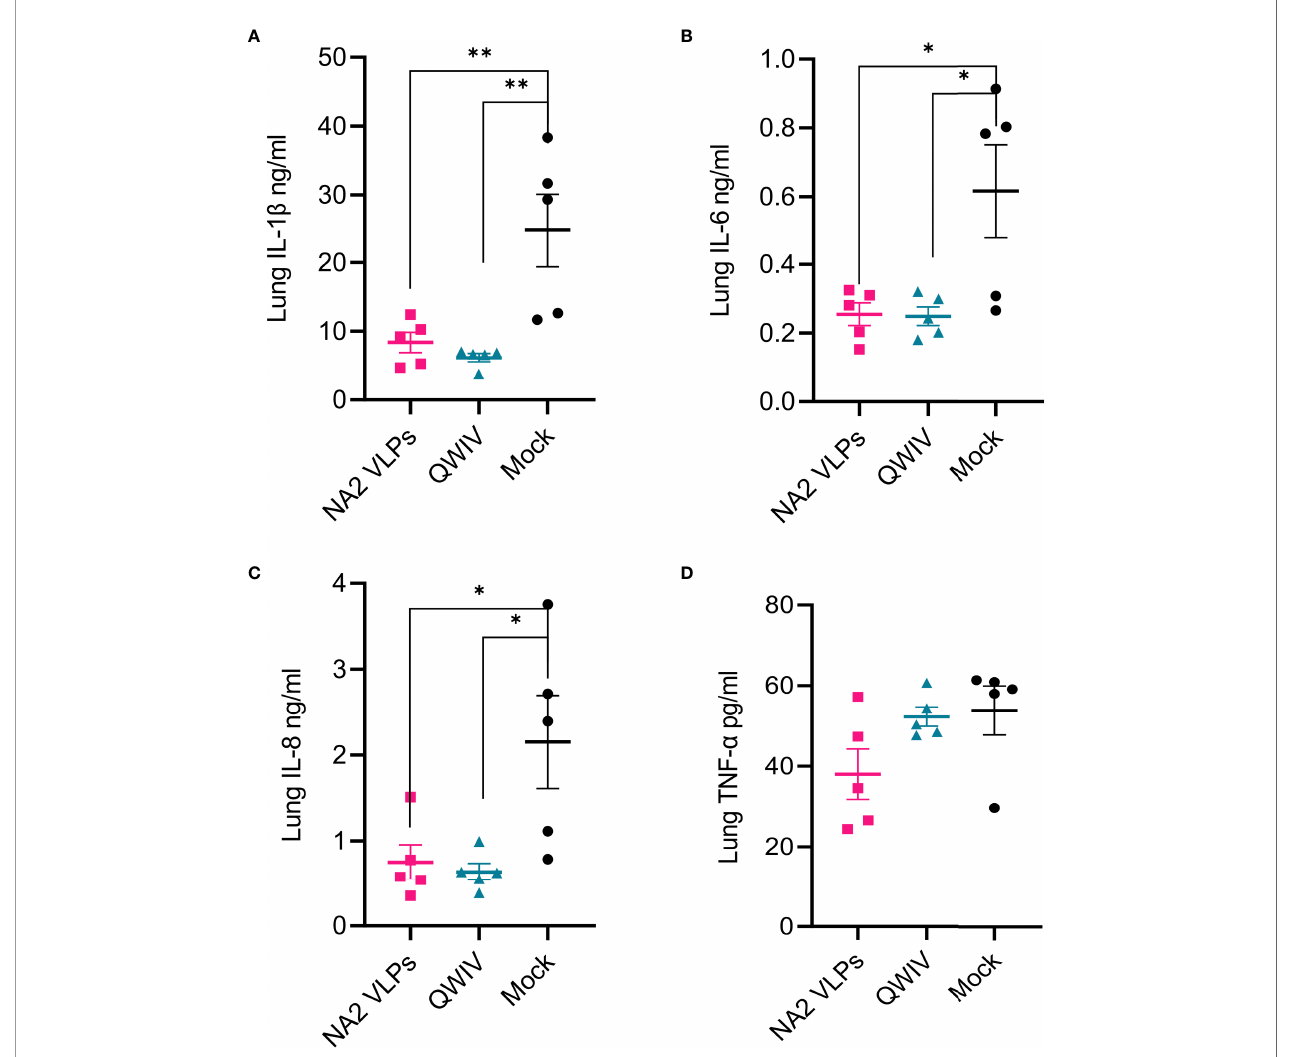
FIGURE 8 | Vaccination with NA2 VLPs reduced lung in fl ammation in pig lungs post-infection. Lung homogenates prepared from tissues collected at necropsy of animals vaccinated with QWIV, NA2 VLPs or adjuvant alone 5 days post-infection, were tested for cytokine and chemokine secretion with MILLIPEX. (A) IL-1 b (B) IL-6 (C) IL-8 (D) TNF- a . Pink squares represent NA2 VLP vaccinated pigs, cyan triangles QWIV vaccinated pigs, and black circles mock vaccinated pigs. Error bars represent SEM. Statistical analysis was performed by one-way ANOVA test. * = p < 0.05; ** = p <